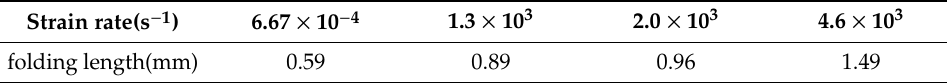
Figure 21. The specimen after dynamic compression test at various strain rates. Table 7. The folding length of the specimen at various strain rates.